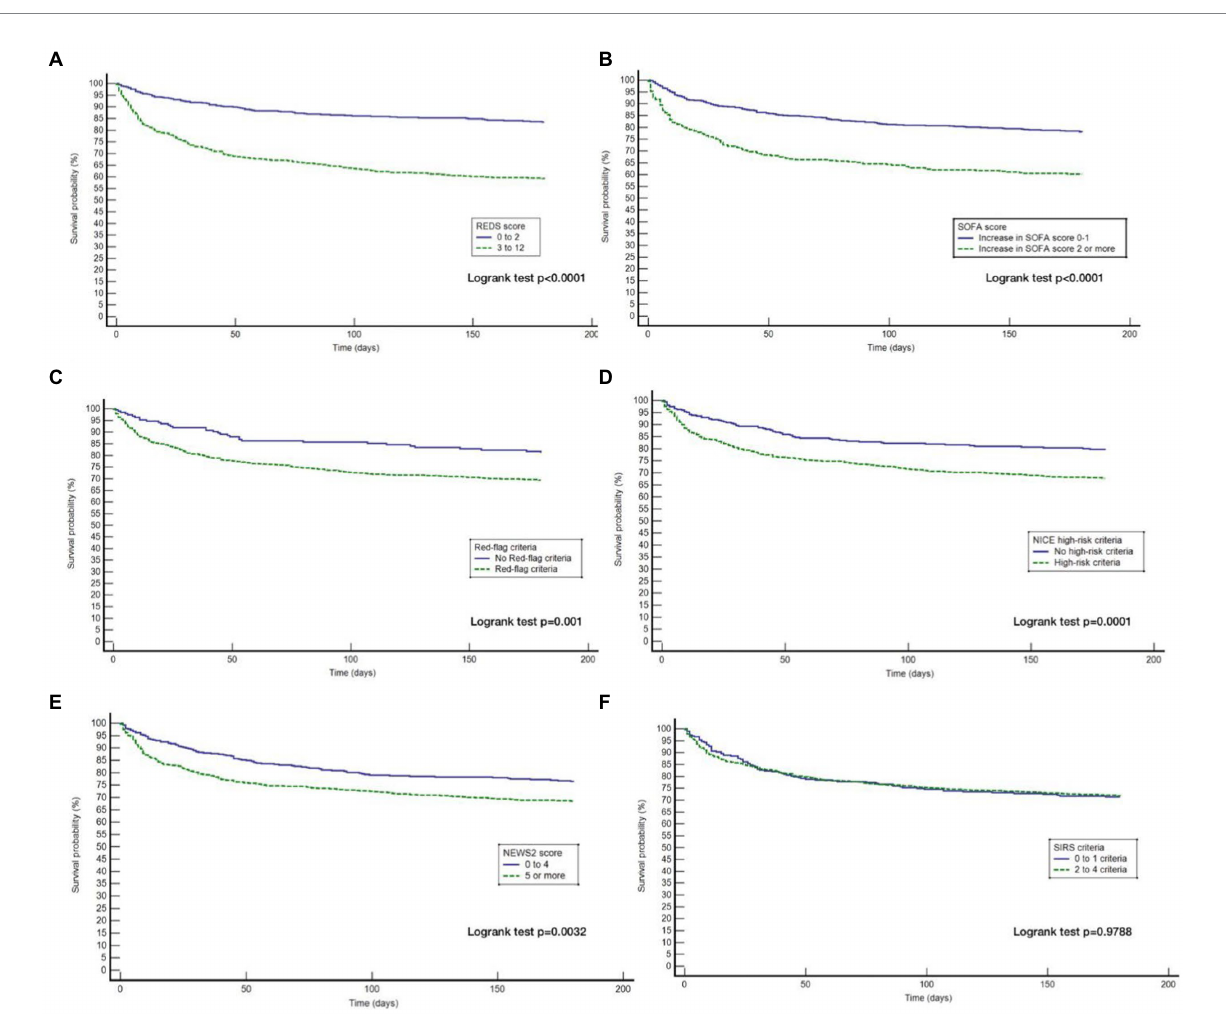
FIGURE 2 Kaplan–Meier curves for 180 day outcome comparing high and low-risk criteria as stratified by the different risk-stratification tools. REDS, Risk- stratification of Emergency Department suspected Sepsis; SOFA, Sequential Organ Failure Assessment; NICE, National Institute for Health and Care Excellence; NEWS2, National Early Warning Score 2; SIRS=Systemic Inflammatory Response Syndrome; (A) Kaplan Meier curves for 180 day survival as stratified by the REDS score; (B) Kaplan Meier curves for 180 day survival as stratified by the SOFA score; (C) Kaplan Meier curves for 180 day survival as stratified by the Red = flag criteria; (D) , Kaplan Meier curves for 180 day survival as stratified by the NICE criteria; (E) Kaplan Meier curves for 180 day survival as stratified by the NEWS2 score; (F) Kaplan Meier curves for 180 day survival as stratified by the SIRS